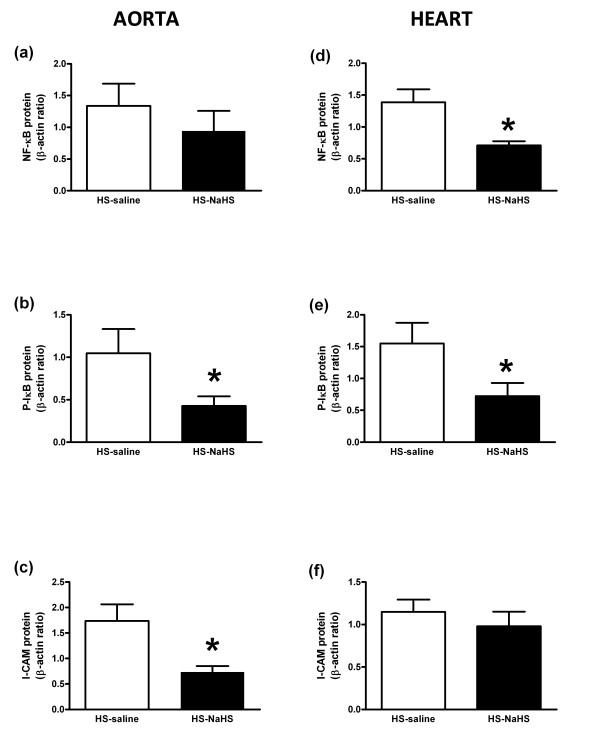
Effects of NaHS on inflammatory pathway signaling. (a, d) Western blots revealing NF-kB expression in the aorta (a) and in the heart (d). (b, e) Western blots revealing P-IκB expression in aorta (b) and in heart (e). (c, f) Western blots revealing I-CAM expression in aorta (c) and in heart (f). Proteins are expressed in the whole lysate of aorta (n = 6) and heart (n = 6) from two groups of rats. Densitometric analysis was used to calculate normalized protein ratio (protein to β-actin). Data are expressed as mean ± SD. *P < 0.05, significantly different between HS-saline and HS-NaHS groups.